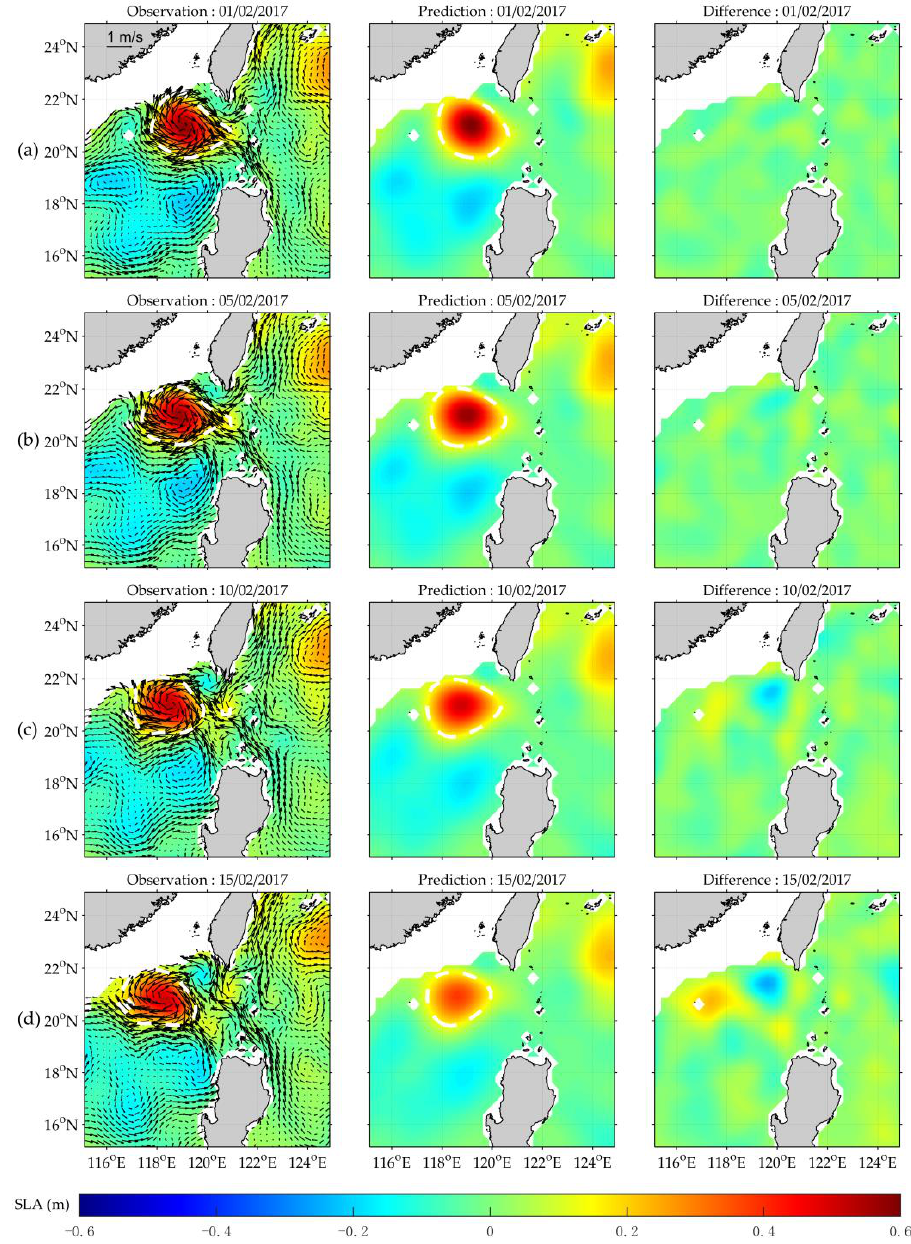
Figure 14. Comparison between observed and predicted SLA at ( a ) day 1, ( b ) day 5, ( c ) day 10, ( d ) day 15. The white dashed line represents the 0.15 m contour, and the red area around the white dashed line are the eddy shedding and the abnormal anticyclone eddy. The left column shows the results from observation, the middle column shows the results from the prediction, and the right column shows the difference between the observed and predicted SLA . Black vectors are the variation of geostrophic current.